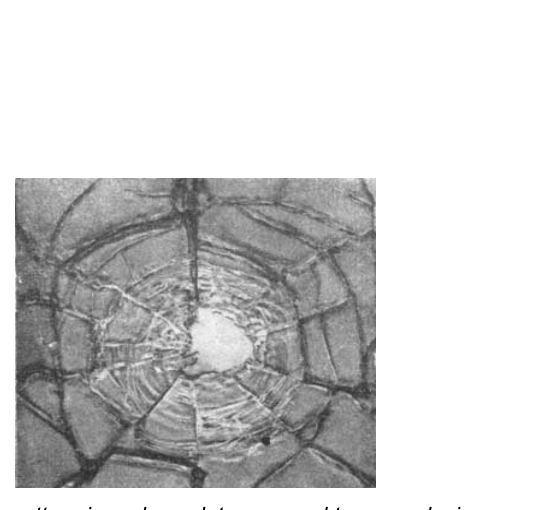
Figure 7 – Fracture pattern in a glass plate exposed to an explosion pressure of 2.8·10 9 Pa 2.8·10 9 Pa